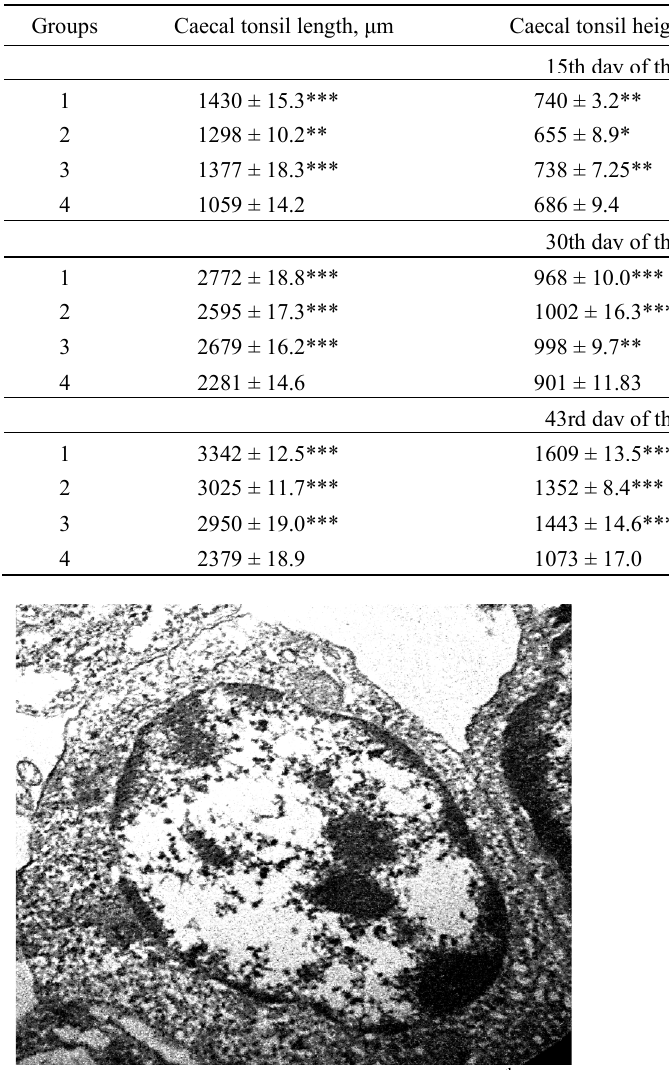
Fig. 12. Electronogram of chicken’s lymphocytes, the 4 th (control) Fig. 13. Electronogram of chicken’s lymphocytes, the 1 st group, 30 th day. x 8000 group, 30 th day of the test. The nucleus is contoured, with a perinuclear zone of enlightenment, rich in chromatin. x